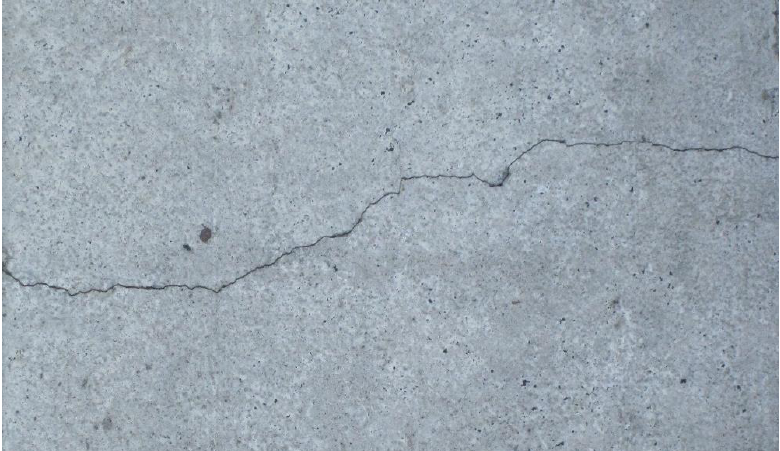
Figure 6. Restrained shrinkage cracking that occurred in a roadside concrete curb; this crack initiated within 56 days of concrete placement; the curb was cured with curing compound.